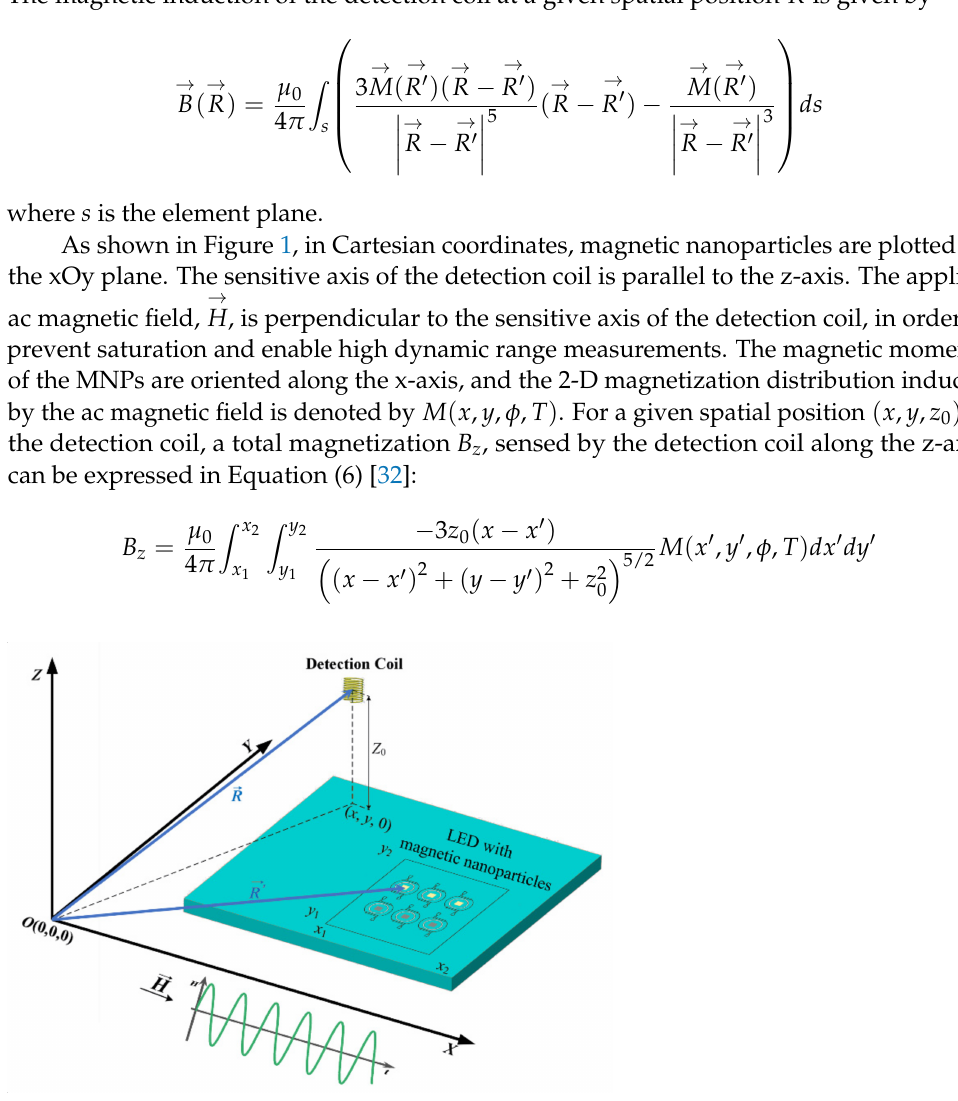
Figure 1. Configuration of the 2-D scanning setup. The 2-D MNPs distribution (a rectangle) is on the ( x , y ) plane. MNPs are exposed to a homogeneous ac magnetic field axis ( z -axis) of the detection